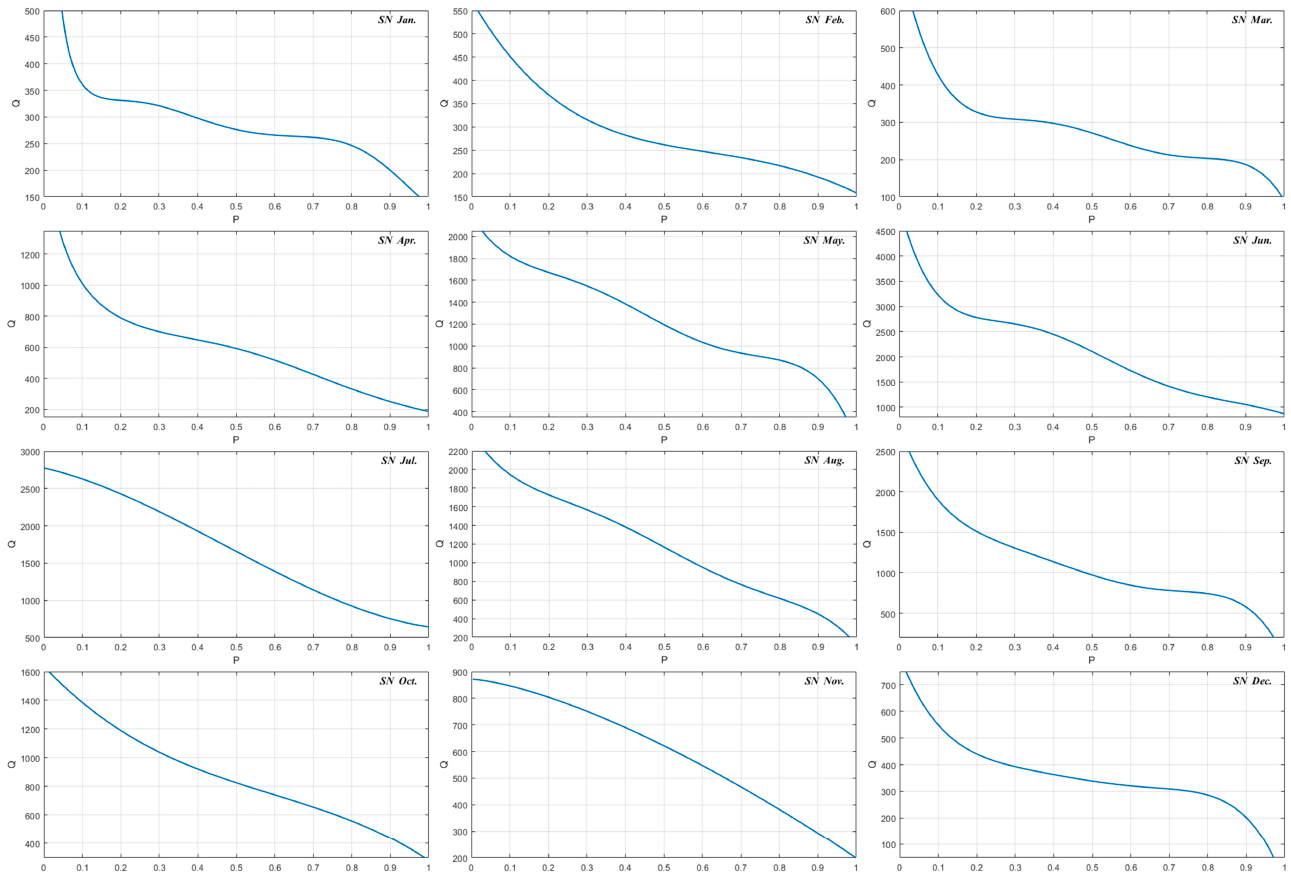
Figure A3. Monthly fitted FDC of Sinan section.